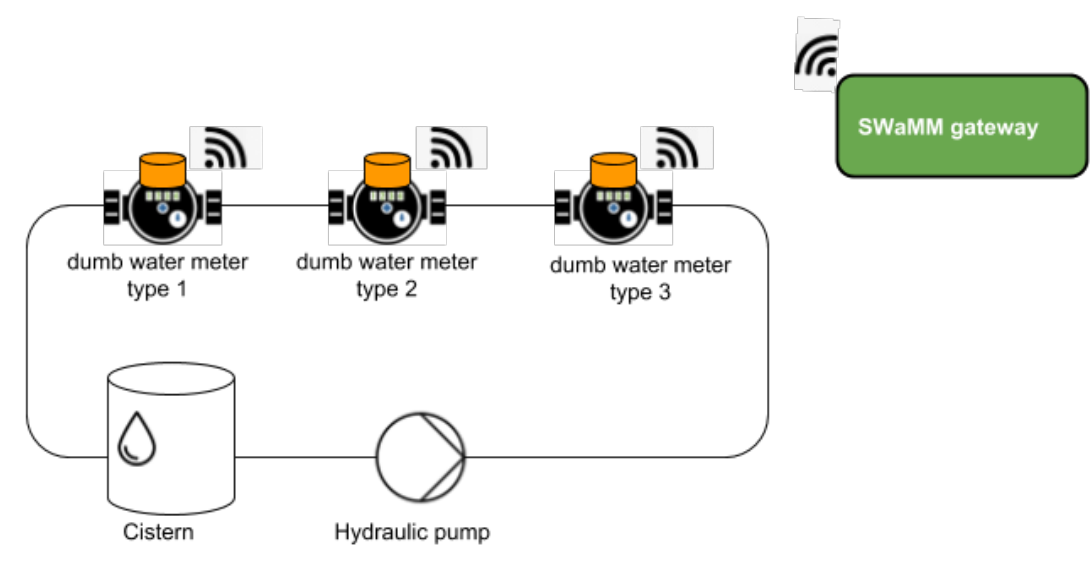
Figure 13. The hydraulic network